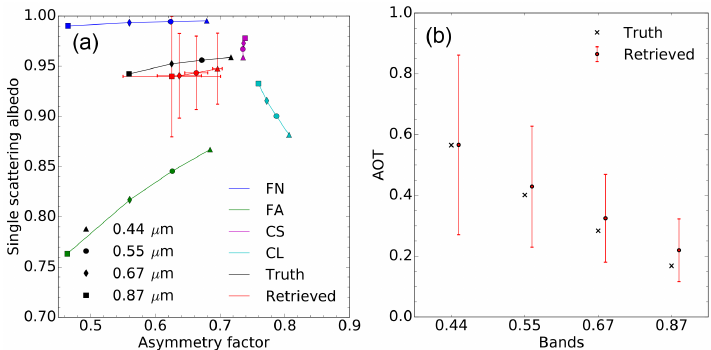
Figure 9. Same as Fig. 5 but for experiment